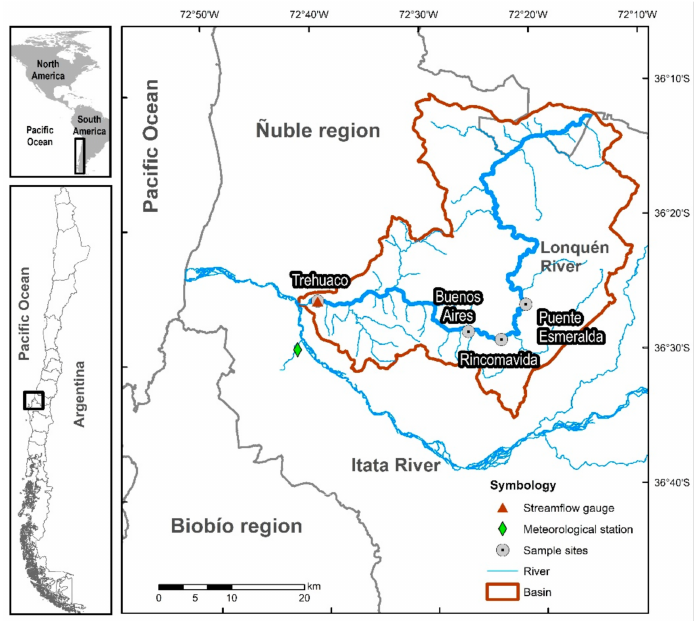
Figure 1. Map of the study area, the basin of the Lonqu é n River in Mediterranean Chile.